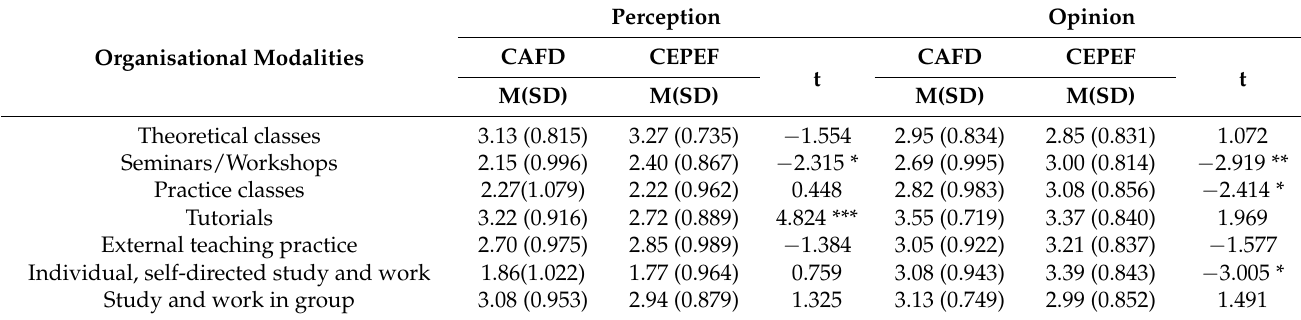
Table 3. Comparison of the perception and opinion on the organizational modalities as a function of degree